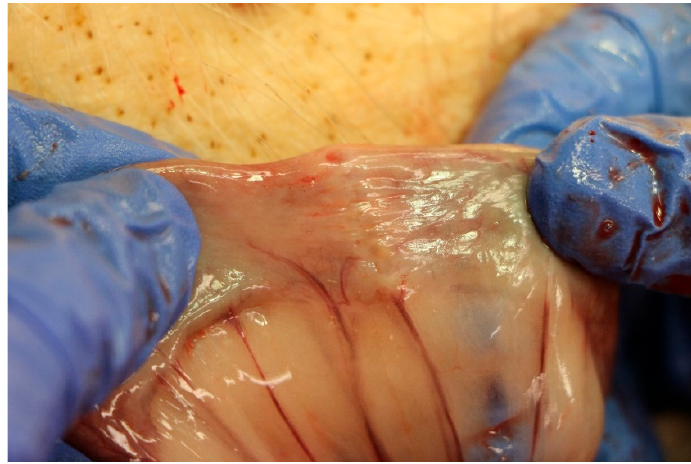
Figure 1. Example of the macroscopic impression of the anastomosis at the time of explantation.